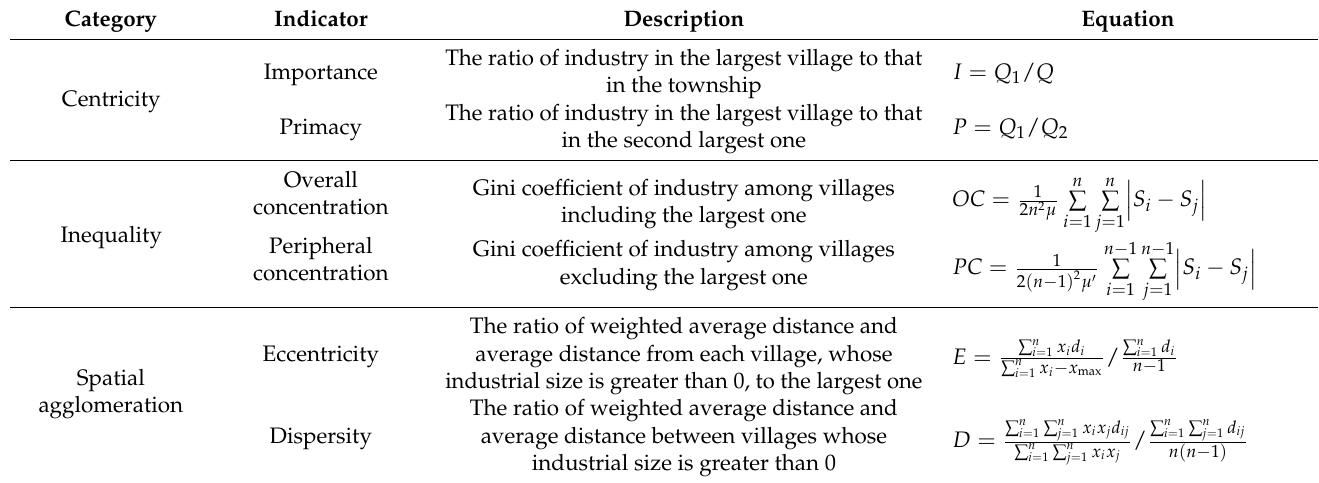
Table 2. Index system of industrial pattern at the township